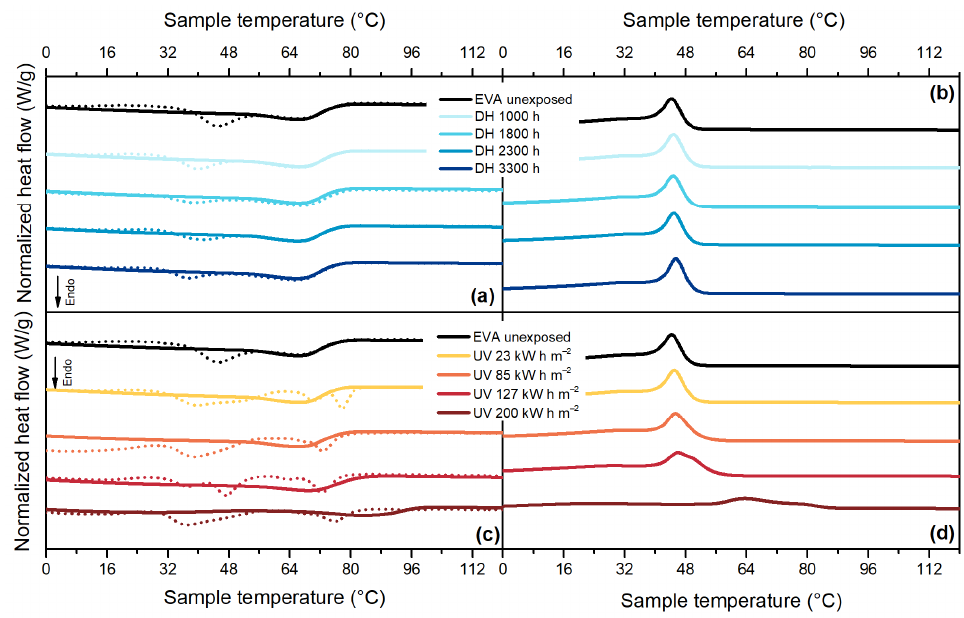
Figure 8. Differential scanning calorimetry (DSC) thermograms for EVA. First heating curves (dashed lines) and second heating curves (full lines) from samples exposed to DH test ( a ). Cooling curves for samples exposed to DH test ( b ). First heating curves (dashed lines) and second heating curves (full lines) from samples exposed to UV test ( c ). Cooling curves for samples exposed to UV test ( d ).